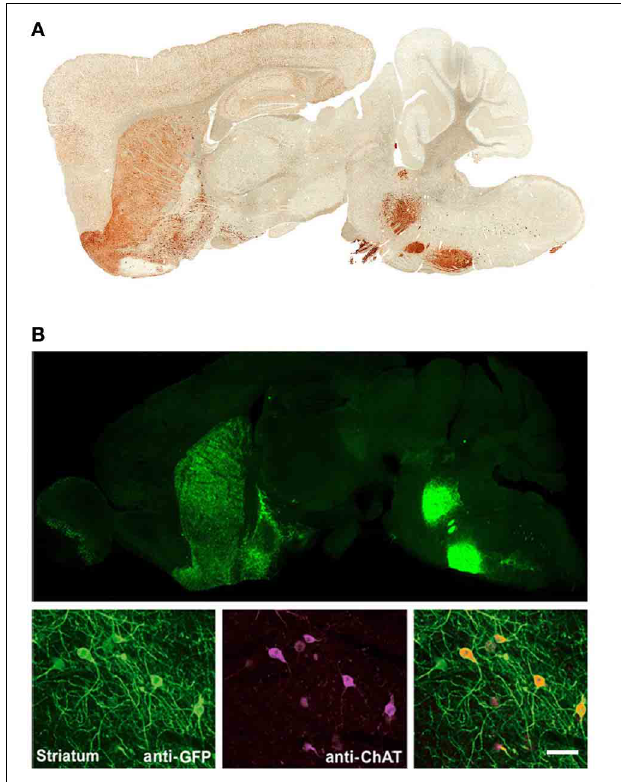
FIGURE 1 | Independent BAC transgenic mouse lines created by modification of the same original BAC clone exhibit highly reproducible cell-type specific transgene expression that recapitulates endogenous gene expression patterns. (A) Sagittal brain section showing EYFP expression for Chat-EYFP line GH293 mice from the GENSAT project. (B) Upper , sagittal brain section showing native EYFP fluorescence for Chat-ChR2(H134R)-EYFP line 6. Lower , high magnification images of anti-GFP and anti-ChAT co-immunostaining demonstrating excellent co-localization. (B) Adapted from Zhao et al. (2011). Scale bar: 100 microns. Note the virtually identical pattern of transgene expression between these two independent lines shown in (A,B) with strong signal detected in known cholinergic nuclei including brainstem motor nuclui (facial nucleus and motor trigeminal nucleus), striatum, olfactory tubercle, and basal forebrain. Both lines were created by modification of BAC clone RP23-246B12 to insert the transgene of interest in place of the Chat